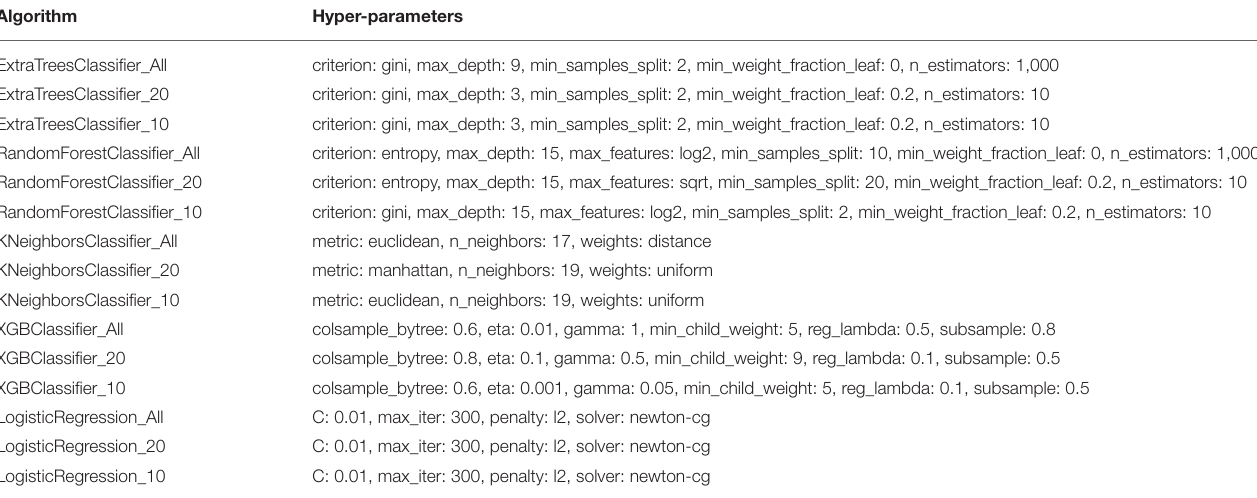
TABLE 6 | Best performing sets of hyper-parameters gathered during the grid-search optimization process. Algorithm